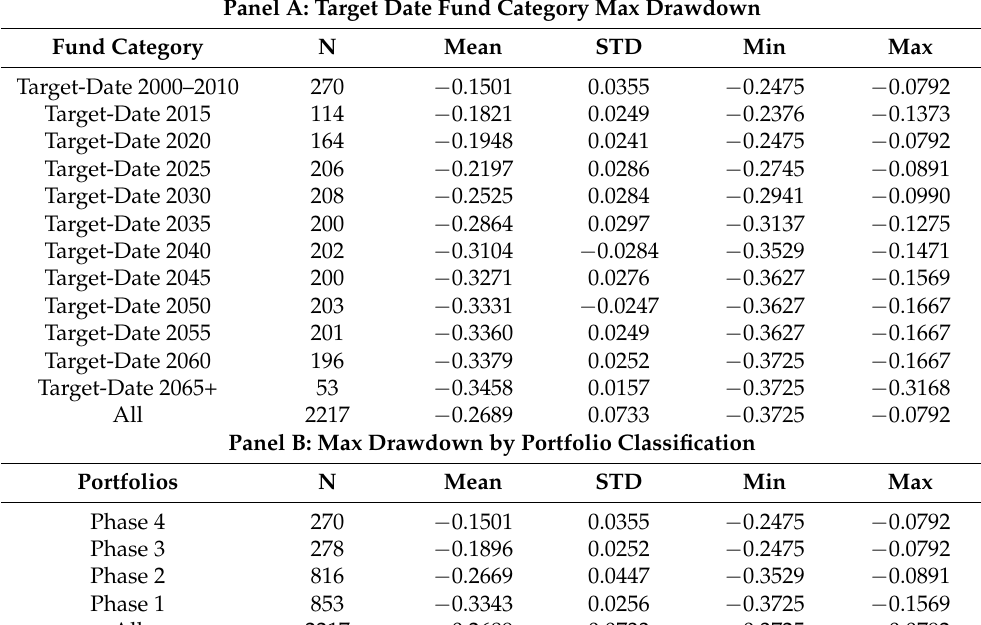
Table 2. Maximum Drawdown Statistics (Entire Sample Period). Panel A: Target Date Fund Category Max Drawdown